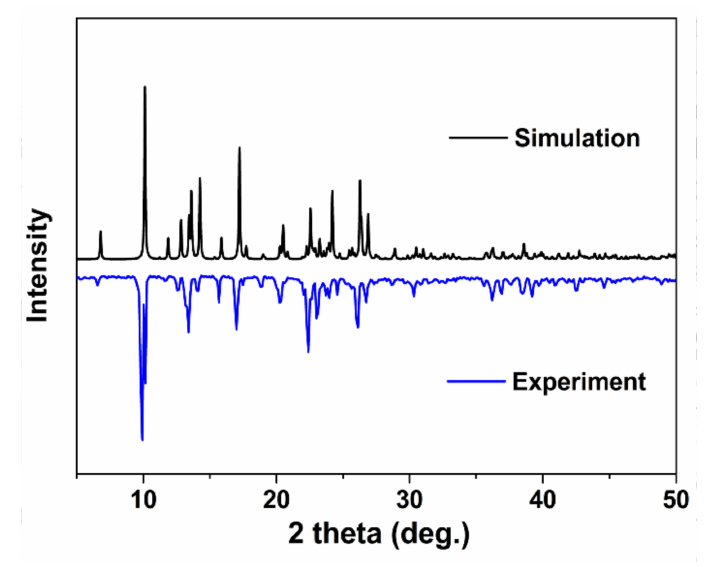
Figure 3. Experimental and simulative powder XRD patterns of Complex.